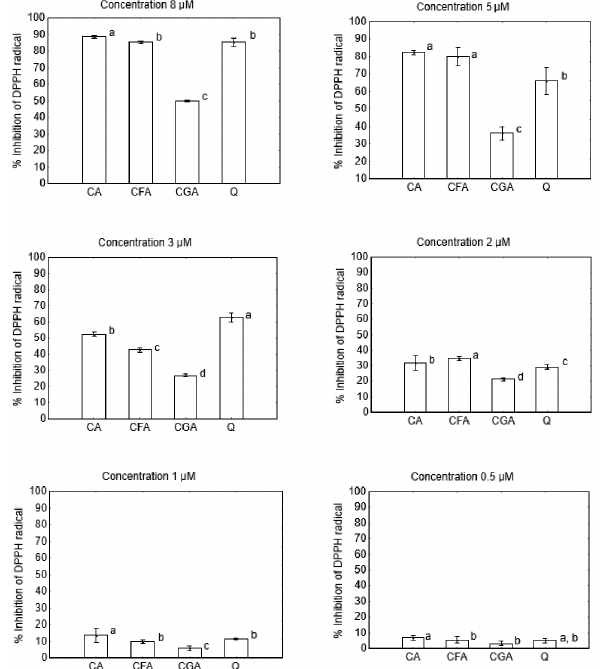
Figure 1. DPPH radical scavenging activity (%) of cichoric acid (CA), caffeic acid (CFA), chlorogenic acid (CGA) and quercetin (Q) for the concentrations 8, 5, 2, 1 and 0.5 μ M. The same letter near the means indicate no significant difference (Tukey test, p < 0.05).